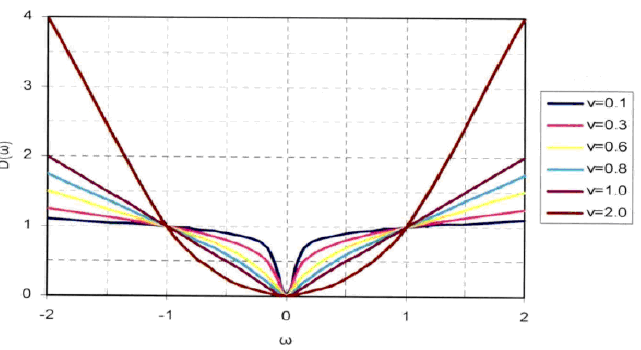
Figure 1. Amplitude frequency characteristic curve of signal integer and fractional differential.